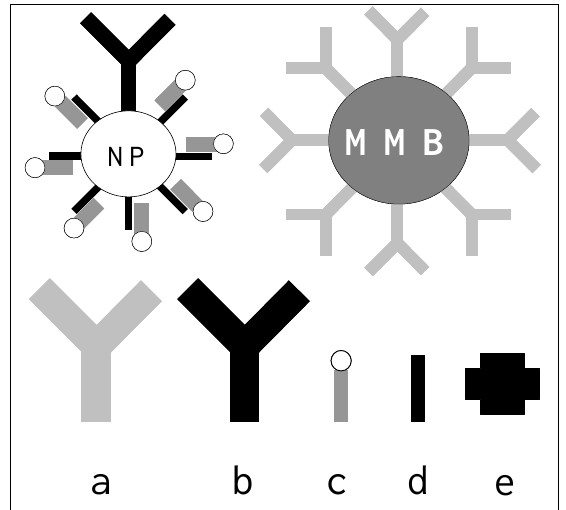
Figure 18. Components of the bio_bar-code assay: MMB Magnetic MicroBeads, NP Nanoparticle a Monoclonal antibody or oligonucleotide b Polyclonal antibody or oligonucleotide c bio–bar-code d Bio–bar-code complementary oligonucleotide e Target molecule (antigen or